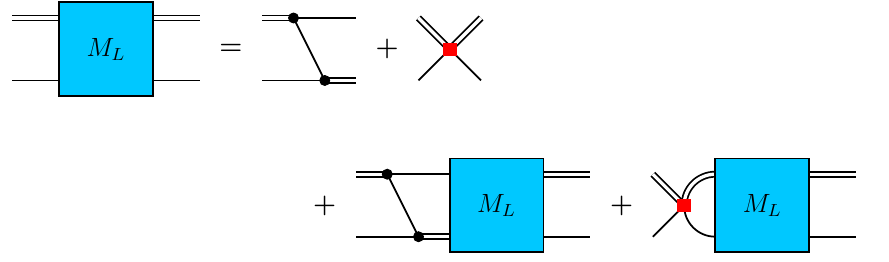
Figure 1 . The Faddeev equation for the particle-dimer scattering amplitude. The red shaded squares denote the particle-dimer coupling.